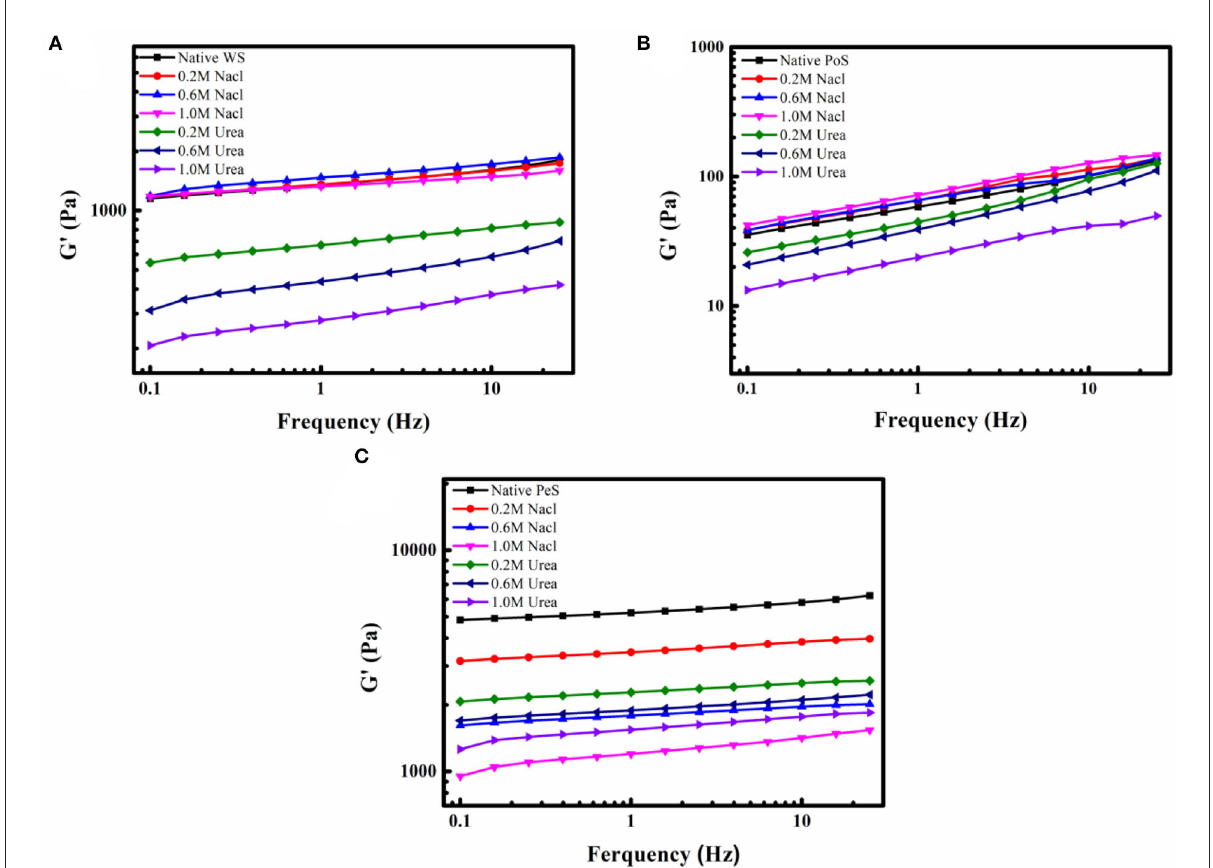
FIGURE3 The G ′ curves of IN-different crystalline starch compound systems with different concentrations of NaCl and Urea: (A) wheat starch, (B) potato starch, (C) pea starch.